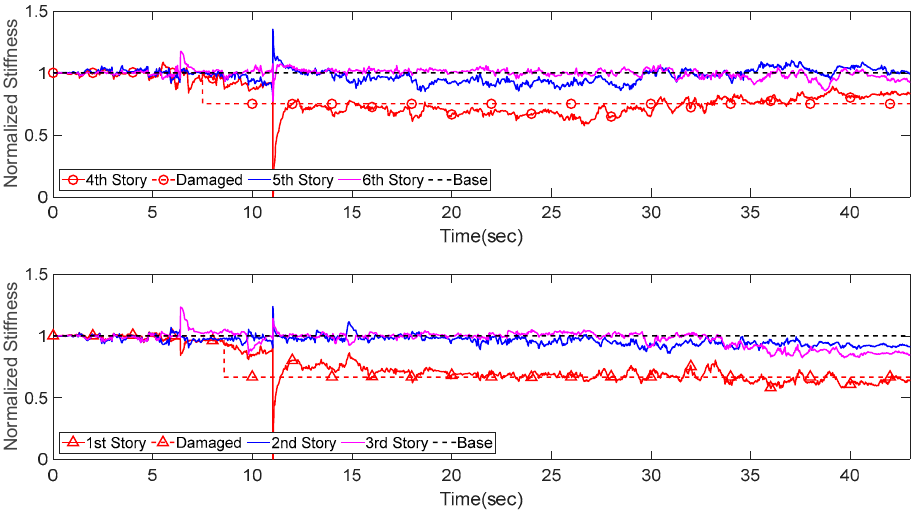
Figure 6. Estimation by MS-KF ME : Scenario 2 with RMS-noise 5%.